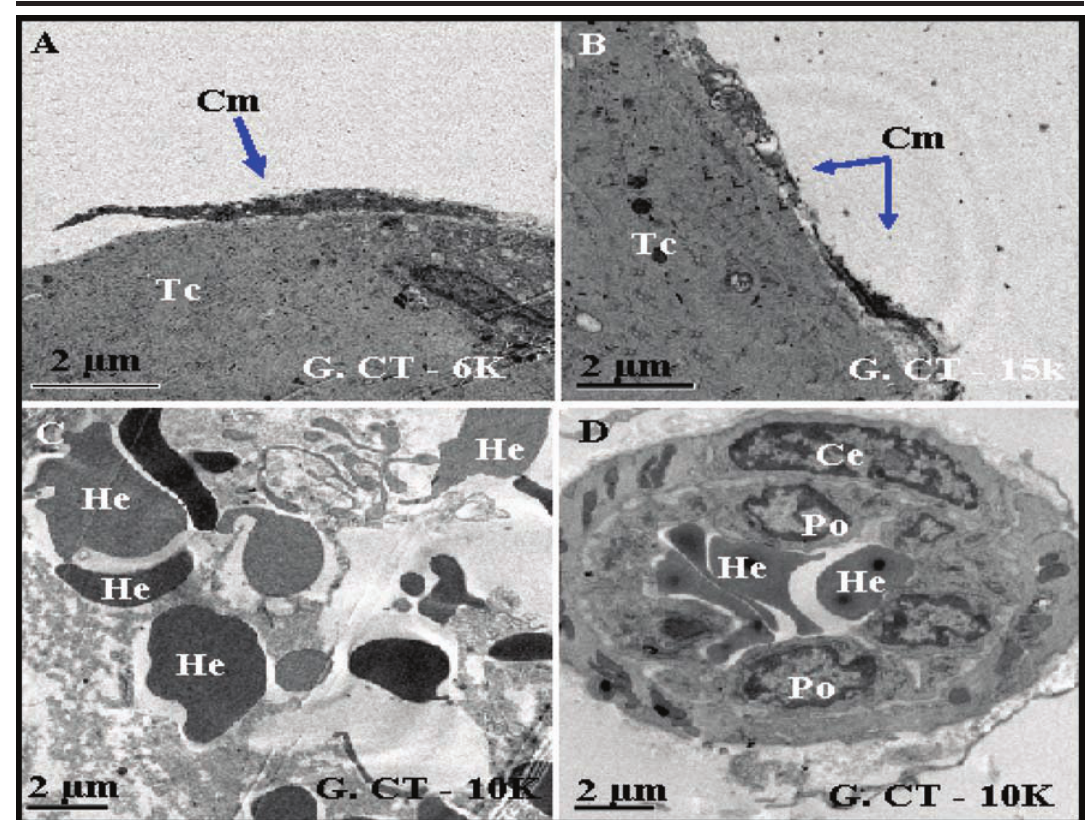
FIGURE 4 - Photomicrography: Mesothelial cell partially detached from the conjunctive tissue, (A). Mesothelial cell with ruptures on the cell membrane and vacuolization, (B). Erythrocyte extravasation, (C) Vascular congestion, (D). Cm, mesothelial cell; Tc, conjunctive tissue; Ce, endothelial cell and Po,